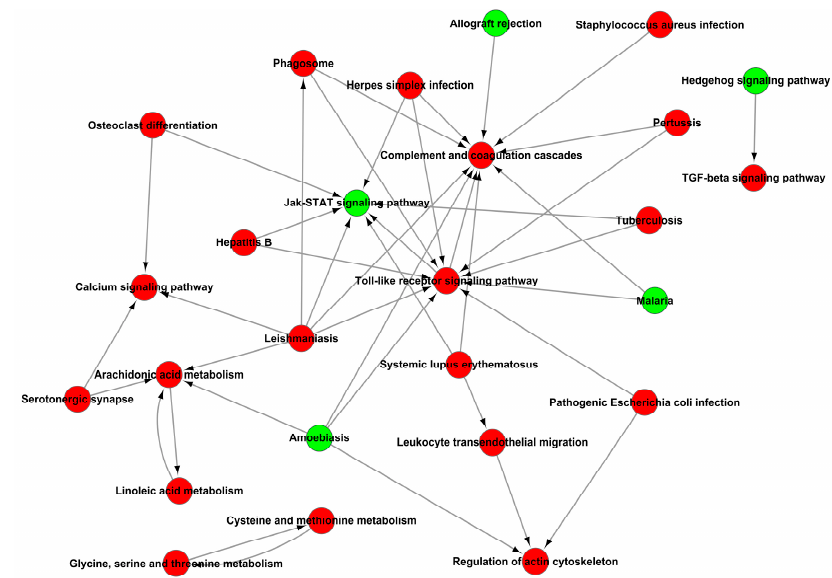
Figure 11. Path-act-network analysis of KEGG signaling pathway enrichment of DEGs.